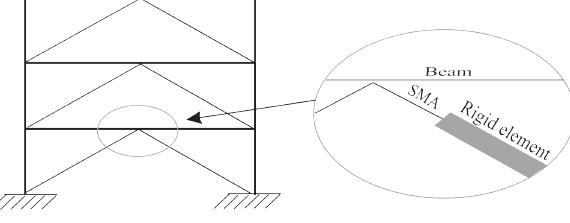
Figure 3: Detail of the SMA brace installed in the three-story frame